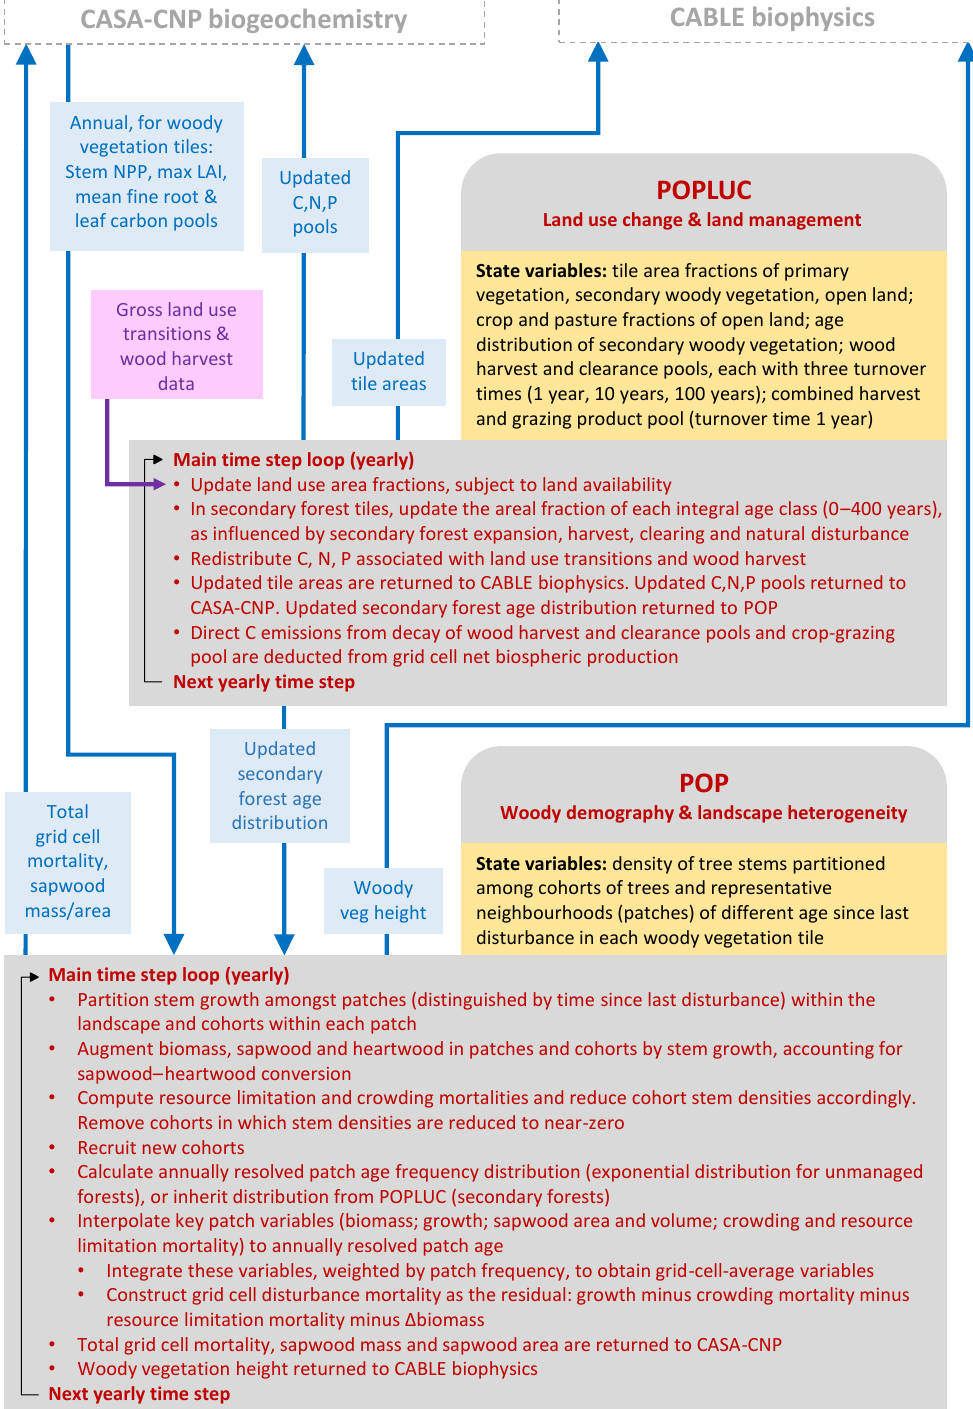
Figure A1. Part 1: CABLE biophysics. Part 2: CASA-CNP biogeochemistry. Part 3: POP and POPLUC components of